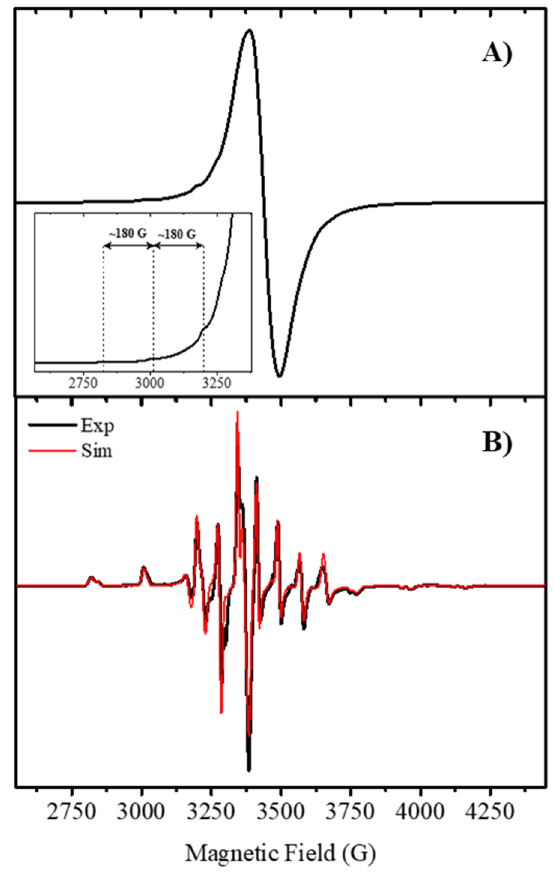
Figure 2. EPR spectrum of VONarg: ( A ) Powdered sample at 120 K, ( B ) Experimental spectrum (black) and simulation (red) of frozen pure DMSO solution at 120 K.